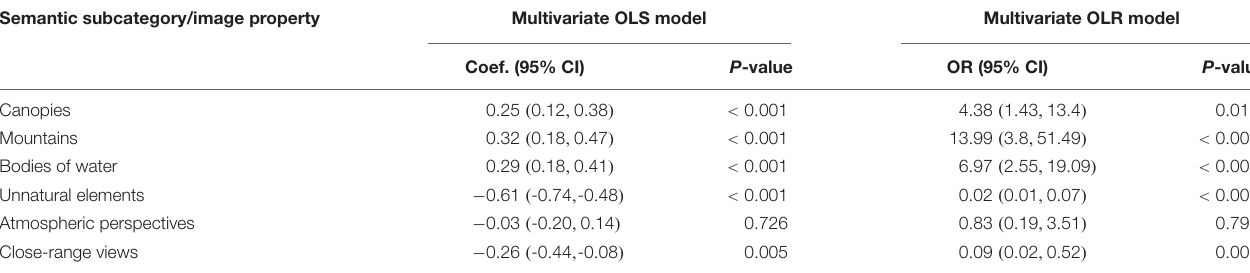
TABLE 4 | Results of multivariate ordinary least squares (OLS) regression and multivariate ordered logistic regression (OLR) models. Semantic subcategory/image property